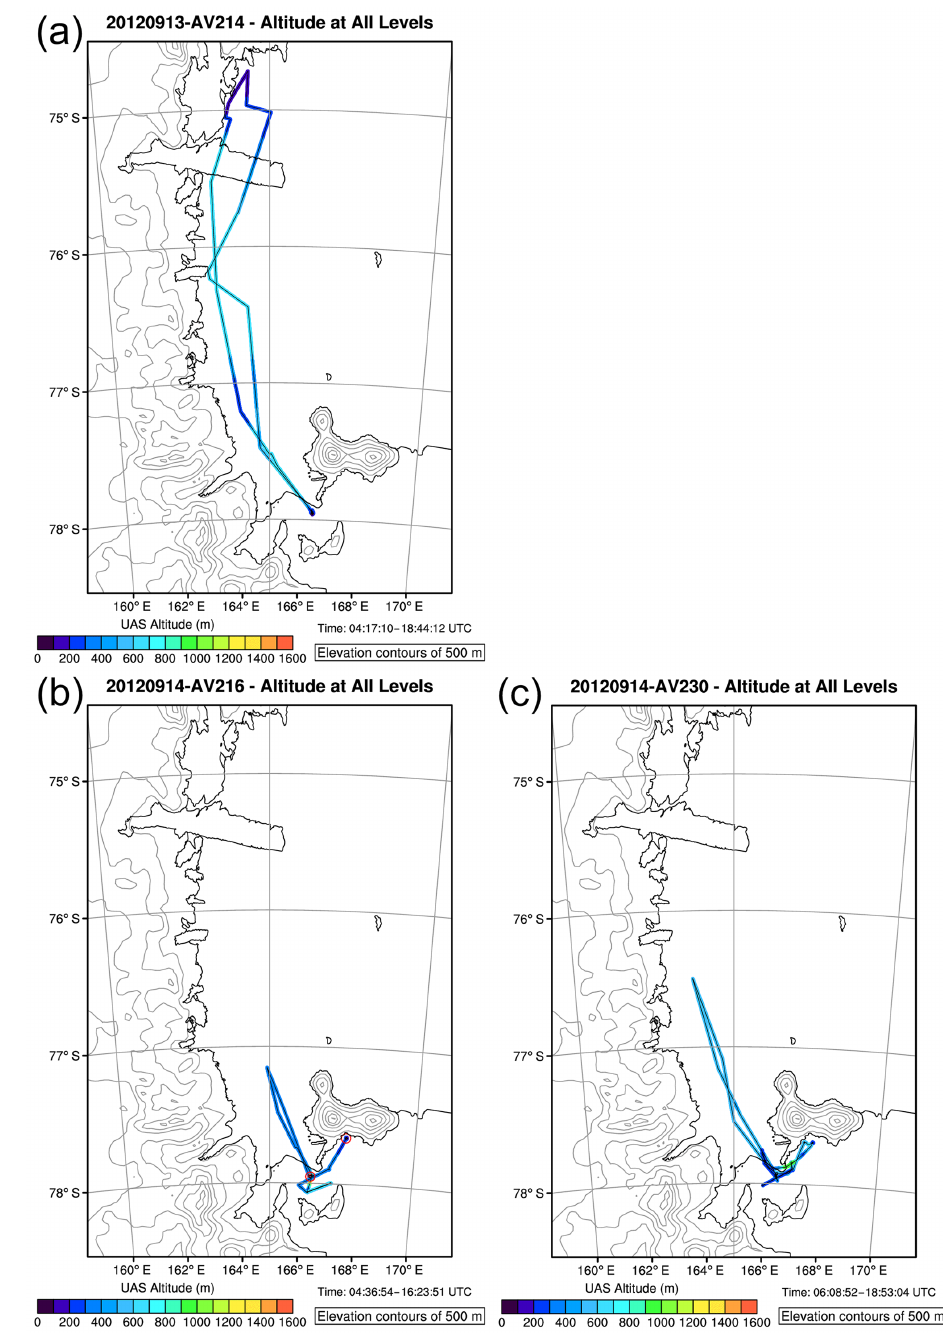
Earth Syst. Sci. Data, 8, 115–126, 2016